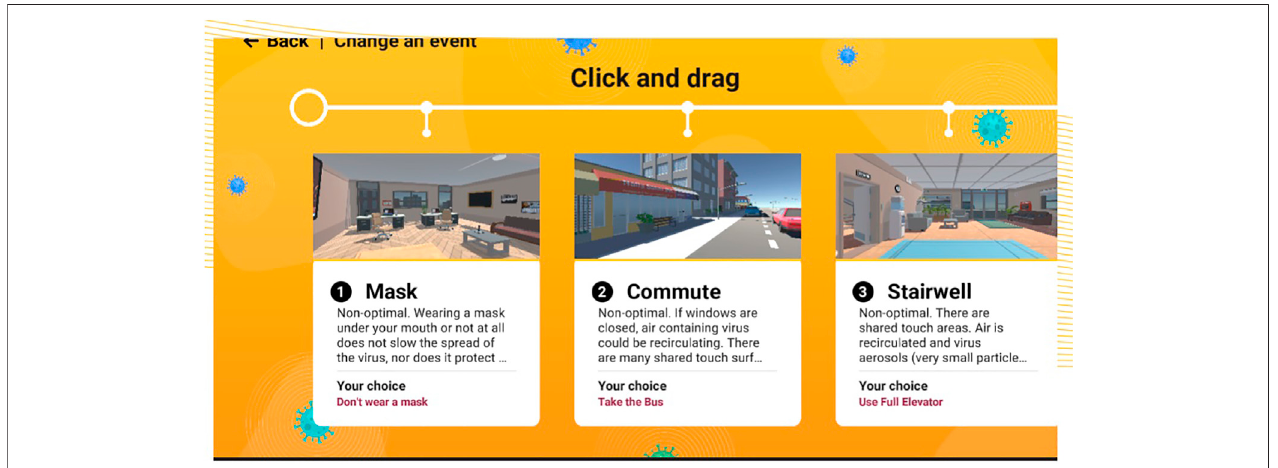
FIGURE 6 | The “ Change an Event ” click and drag line that showed up after the eighth and fi nal decision.